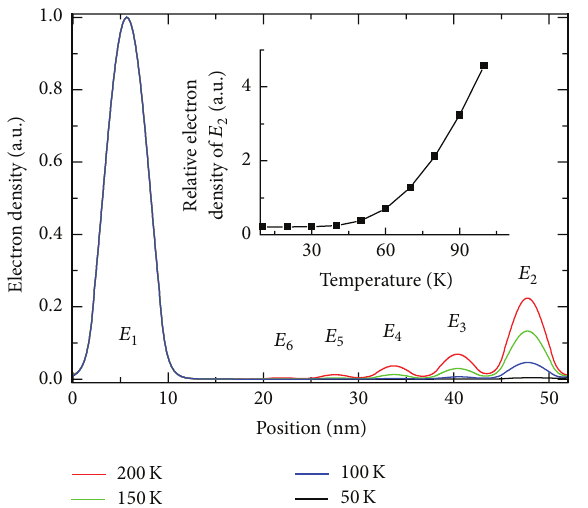
Figure 3: Calculated electron density at different temperatures (normalized). Inset is the electron concentration ratio of 𝐸 2 and 𝐸 1 subband.